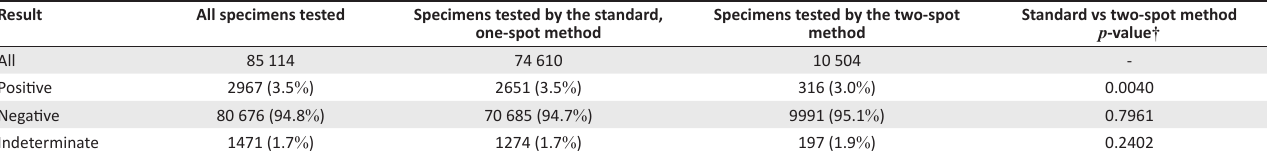
† , p -values < 0.05 were considered statistically significant.